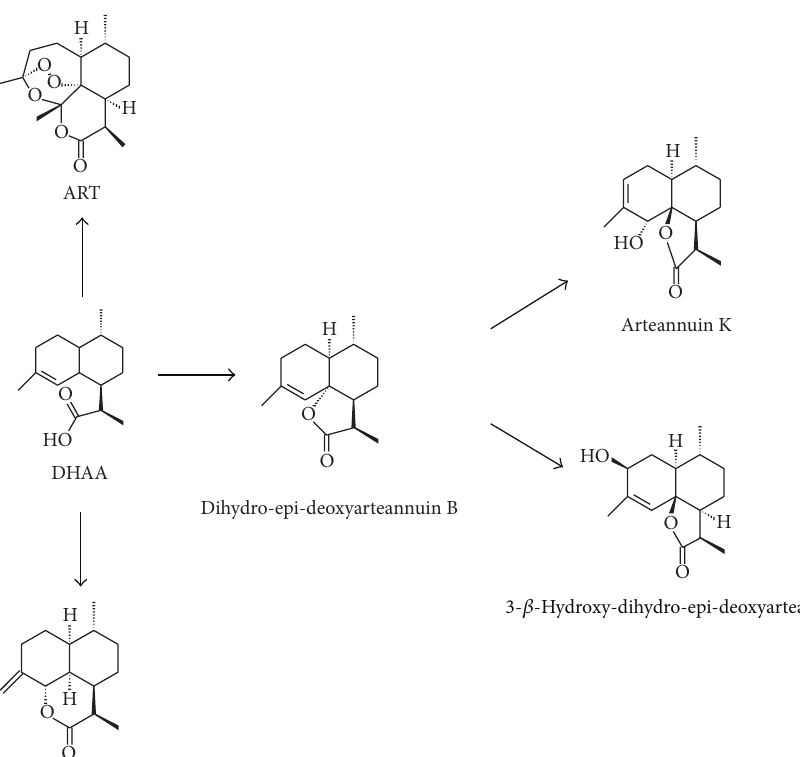
Figure 3: Proposed biosynthesis pathway of ART and its analogs from DHAA in suspension-cultured cells of A. annua .